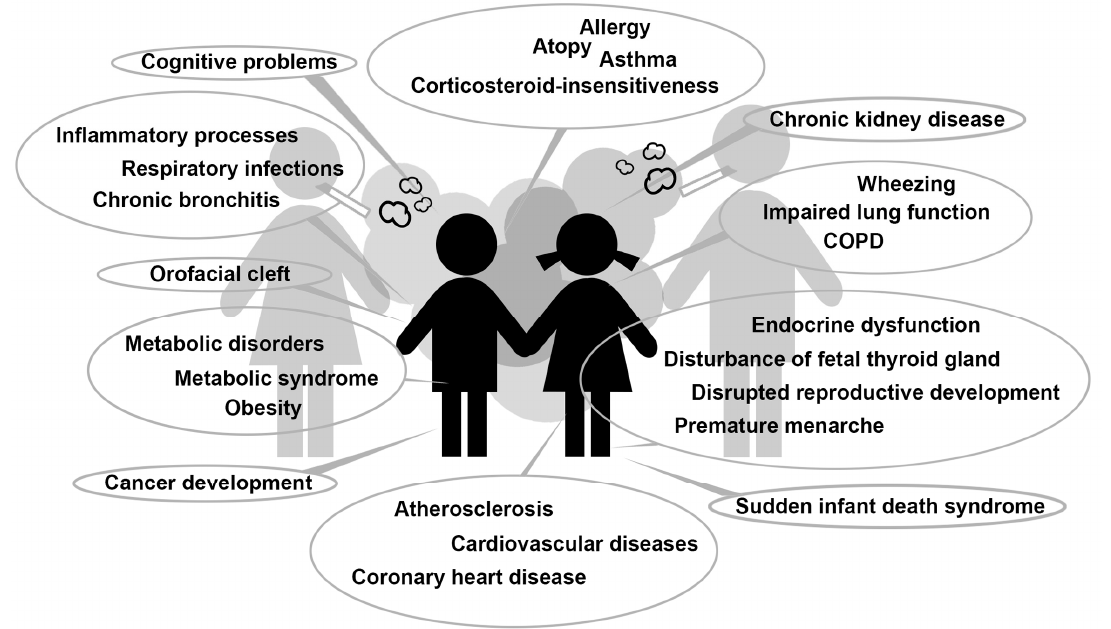
Figure 1. Adverse health effects in children induced by second-hand smoke and prenatal tobacco smoke exposure. COPD = chronic obstructive pulmonary disease.